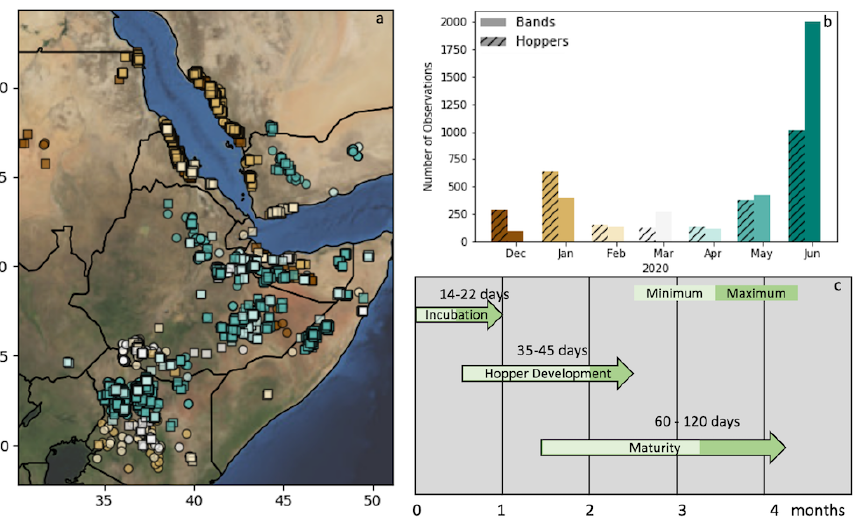
Figure 1. Study Area (WGS84) ( a ) depicting the locust observations in East Africa from December 2019 through June 2020. Solitary hoppers are noted by a circle and bands by squares. The colors of the observations relate to the timing in the ( b ) bar plot of observation counts by month. ( c ) A depiction of the timeline of the desert locust (DL) life cycle from breeding to maturity in the East African environment, as reported in WMO/FAO